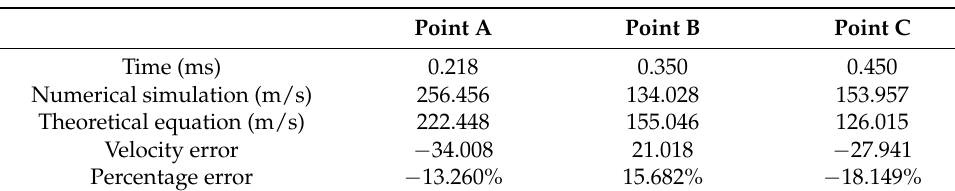
Table 9. Error analysis of head velocity.